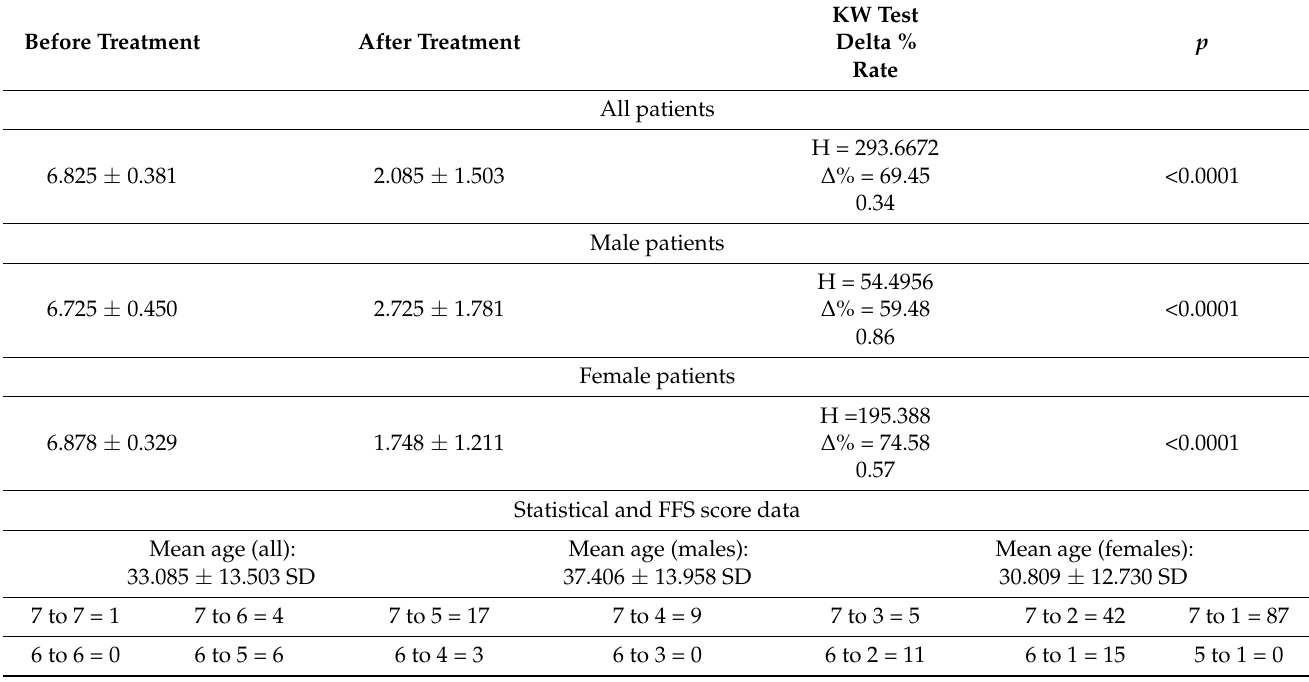
Table 1. Results of fatigue treatment in ME/CFS patients with O 2 -O 3 -AHT (mean ± SD).